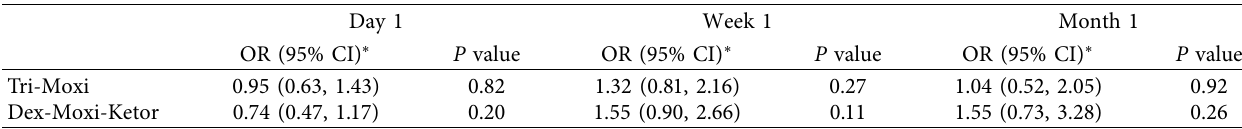
Figure 1: Comparison between treatment groups in anterior chamber inflammation at different postoperative timepoints. Table 3: Corneal edema comparison between compound drugs and standard eyedrop treatment at different time point.